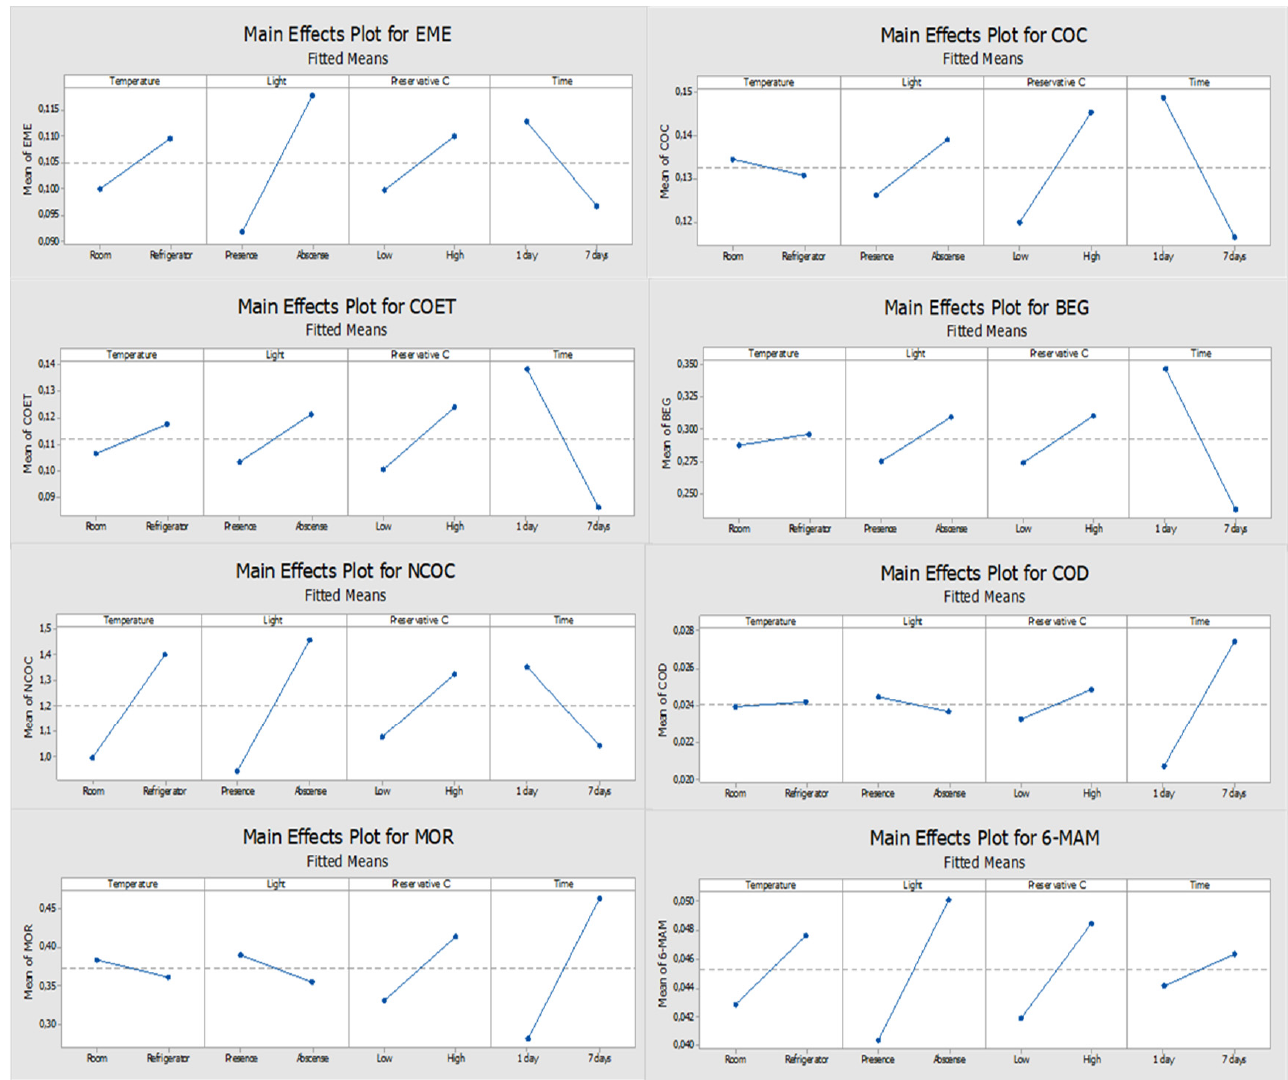
Figure 2. Main effects plots of the compounds when ascorbic acid was used as the preservative; The slope of the lines represents the effect of the response for the factors under study: temperature (room or refrigerator (4 °C)), light (presence or absence), preservative concentration level (low or high), and storage time (1 or 7 days).